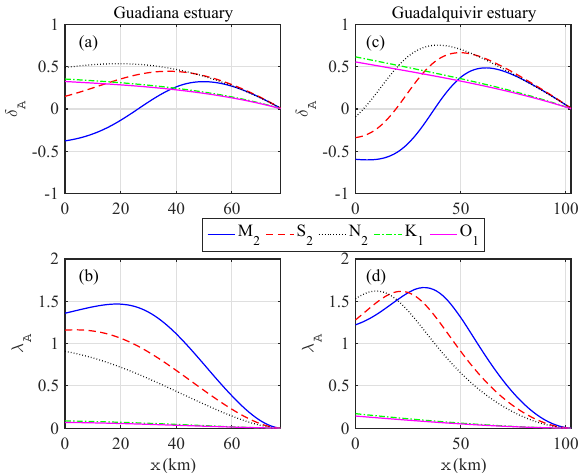
Figure 11. Longitudinal variations in damping/amplification num- ber δ A (a, c) and celerity number λ A (b, d) in the Guadiana estu- ary (a, b) and Guadalquivir estuary (c, d) in the absence of mutual interaction between different tidal